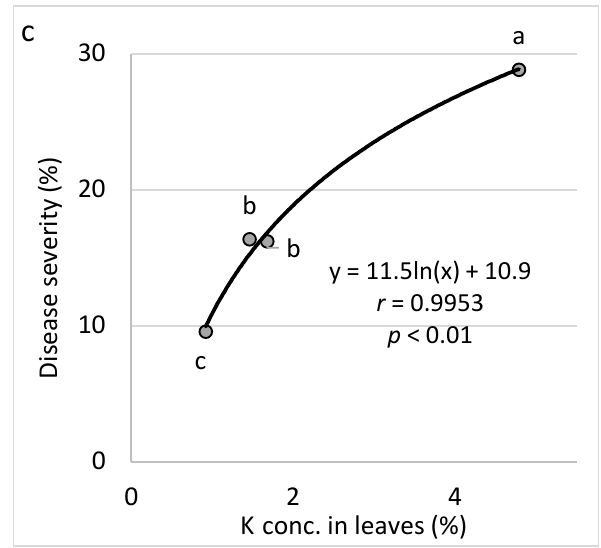
Figure 3. Effect of K concentration treatments in the irrigation water on cucumber downy mildew (CDM, Pseudoperonospora cubensis ). K concentration in the leaves is presented in relation to K con- centration in the irrigation water ( a ), CDM severity is presented in relation to K concentration in the irrigation water ( b ), and CDM severity is presented in relation to the K concentration in the leaves ( c ). The disease was evaluated on a 0 to 100% severity scale, where 0% = healthy leaves and 100% = leaves completely covered by CDM symptoms. Values of the area under the disease progress curve (AUDPC) were calculated for 18 days after disease onset. In each graph, values for each K treatment followed by a common letter are significantly not different from each other according to Tukey-Kramer’s HSD test ( p ≤ 0.05). The regression formulas of the drawn trend lines are presented, and the correlation Pearson regression values ( r ) are presented along with significance levels ( p ).